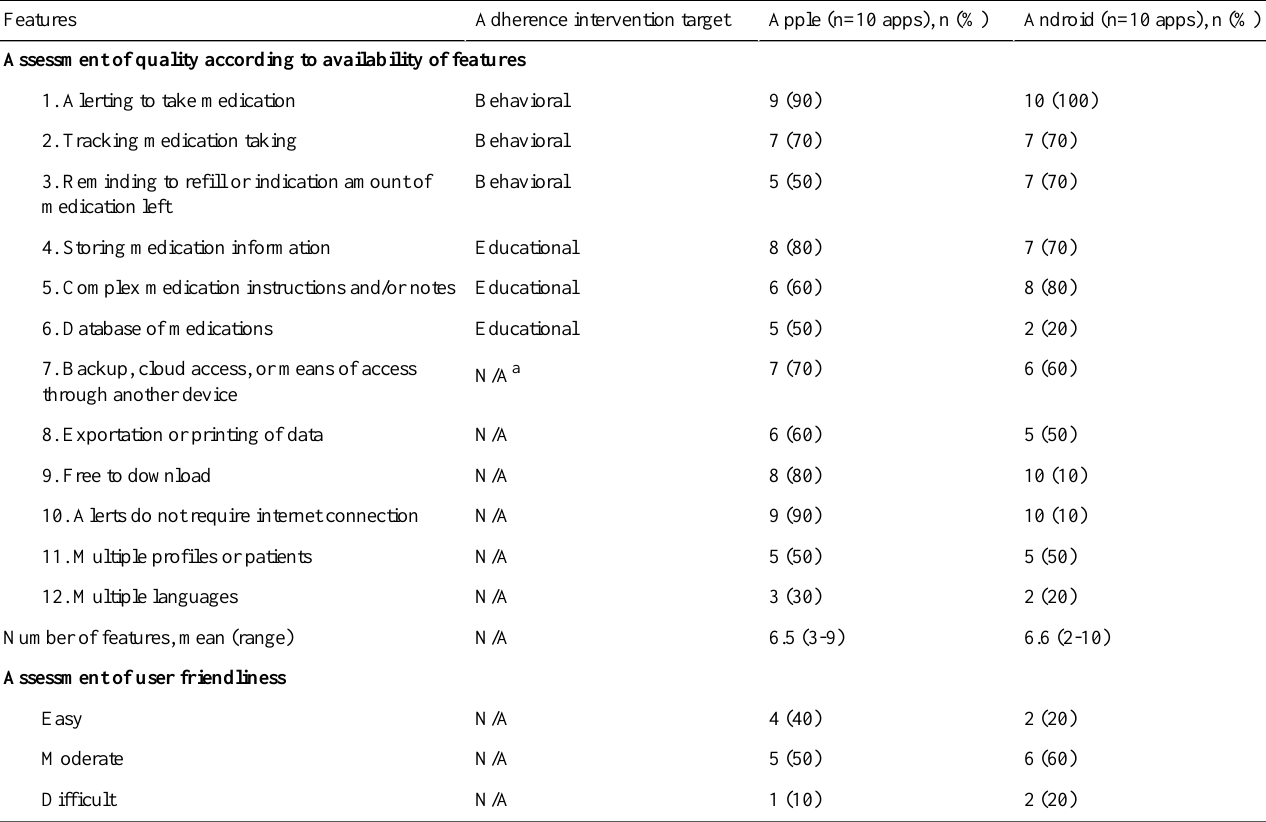
Table 2. Quality assessment and user testing of selected mobile phone medication adherence apps in Apple and Android.